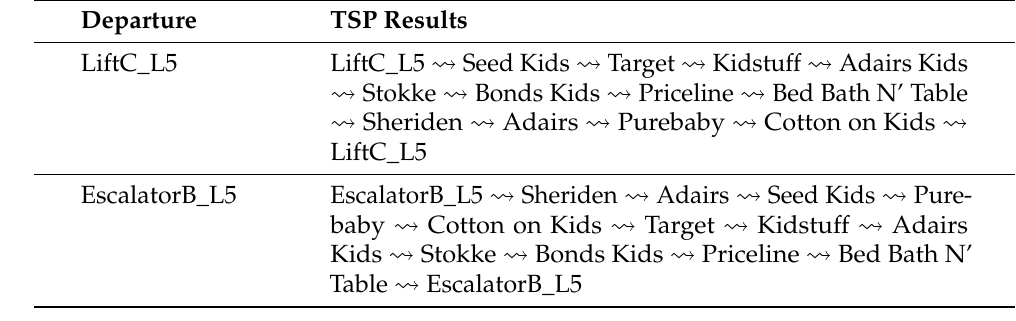
Table 5. TSP results with the two departure locations.